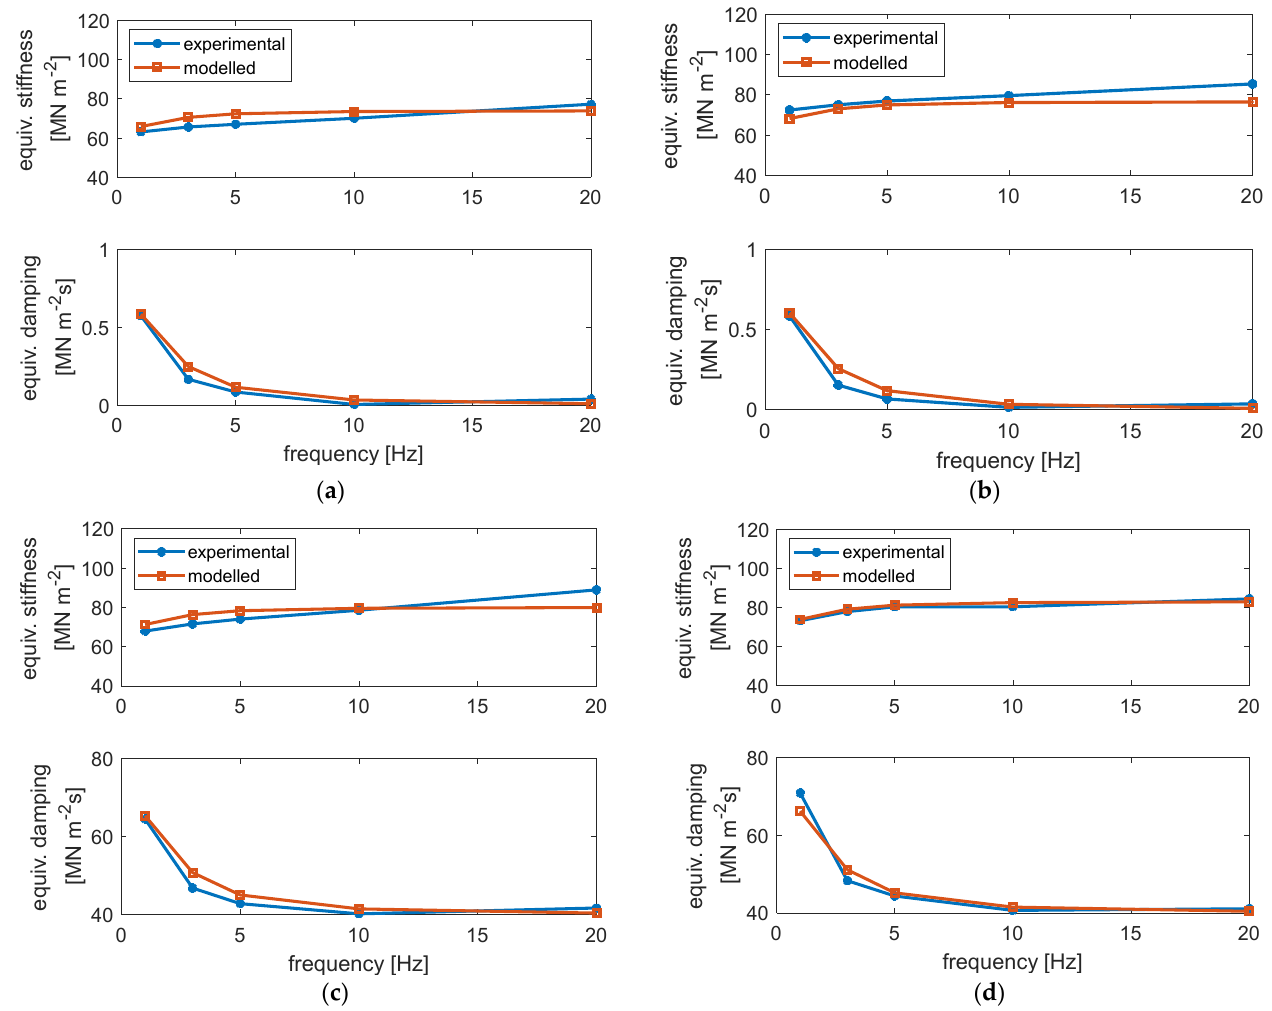
Figure 6. Modelled and experimental equivalent stiffness (upper plot of each part) and viscous damping (lower plot of each part) of unit length of the elastomeric element of the ERS: ( a ) preload of 6 kN; ( b ) preload of 18 kN; ( c ) preload of 37 kN; ( d ) preload of 55 kN.